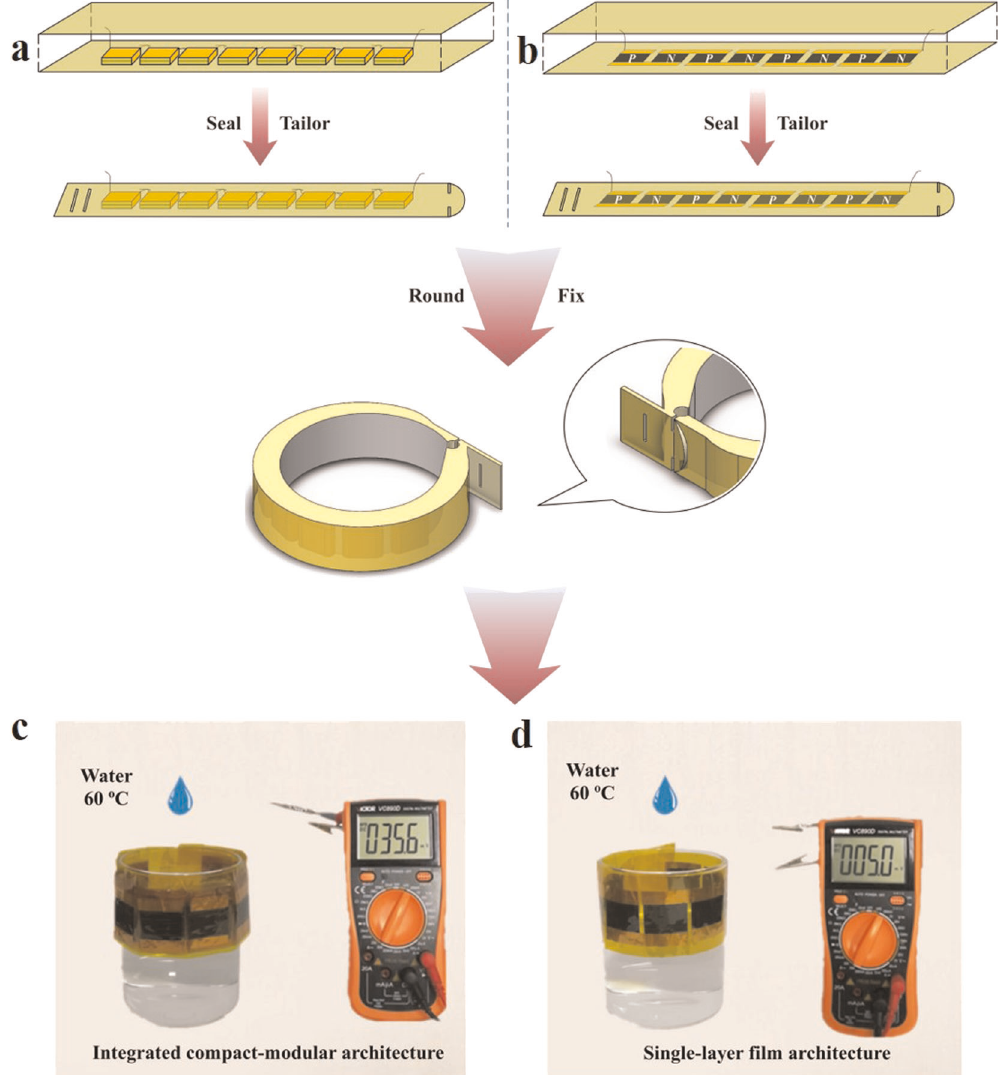
Fig. 3 Schematic illustration of the fabrication procedure of the annular TE devices. a with integrated-module architecture by connecting in series with eight independent modules, each containing three p-n couples of single-layer fi lms with a dimension of 2 × 2 cm 2 , b with single- layer fi lm structure by alternatively connecting in series using four pairs of the p- and n-type fi lms with a dimension of 2 × 2 cm 2 . c , d Photographs showing the output voltages of the annular TE devices at Δ T = 18 ± 2 K for c the integrated-module architecture or d the single- layer fi lm